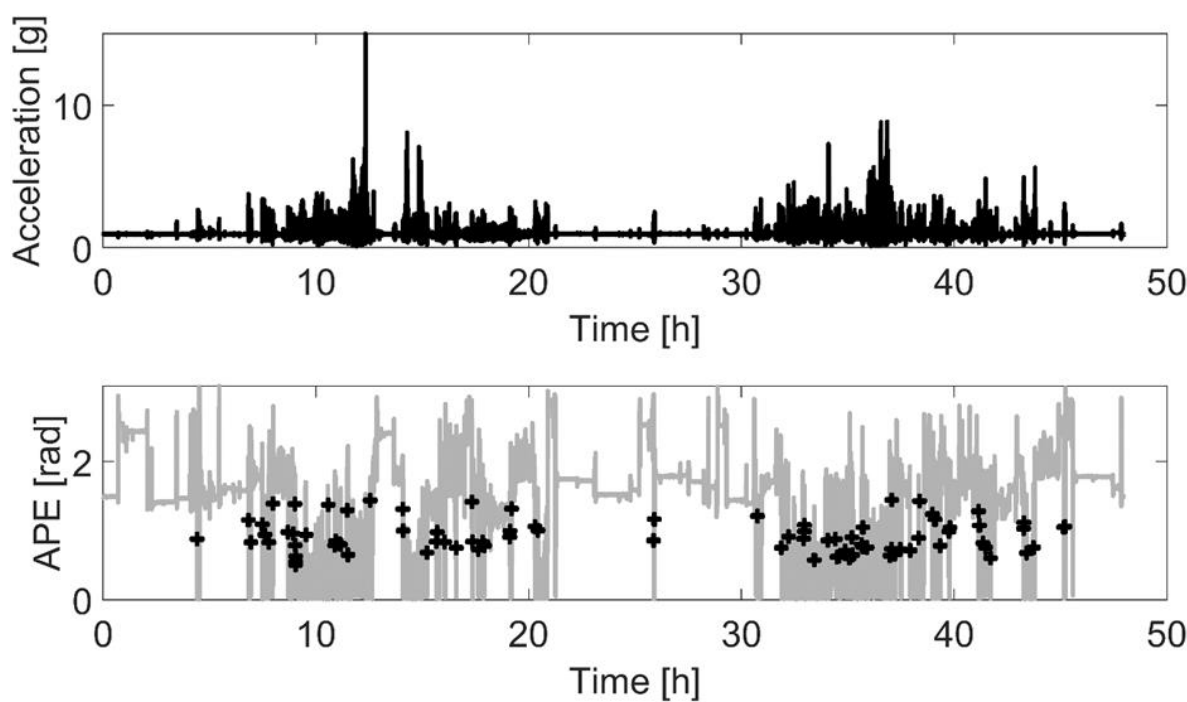
Figure 2. A visualization of the signals used to detect and quantify sit-to-stand (STS) transitions in a free-living environment. The two-day sample starts at midnight and shows the expected diurnal pattern in STS transitions, with very few occurring over the night-time. Top pane: resultant magnitude acceleration. Bottom pane: angle for postural estimation (APE, grey) and the identified STS transitions (black “+”).